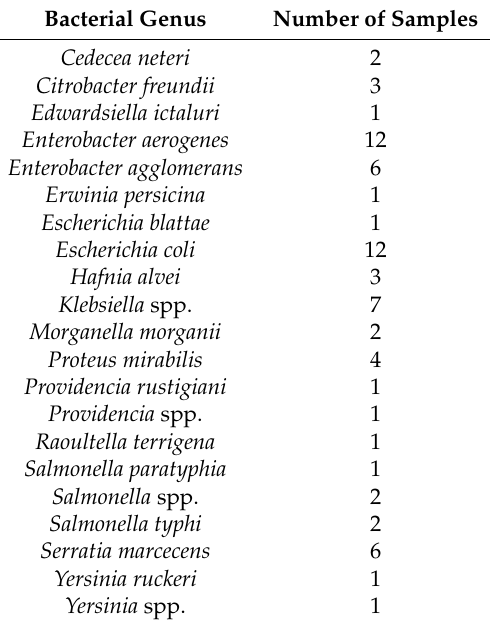
Table 4. Quantification of studied bacterial